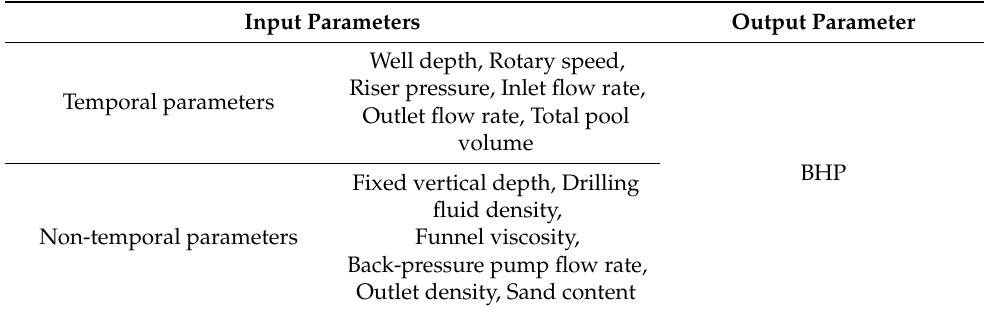
Table 2. Input and output parameters of the